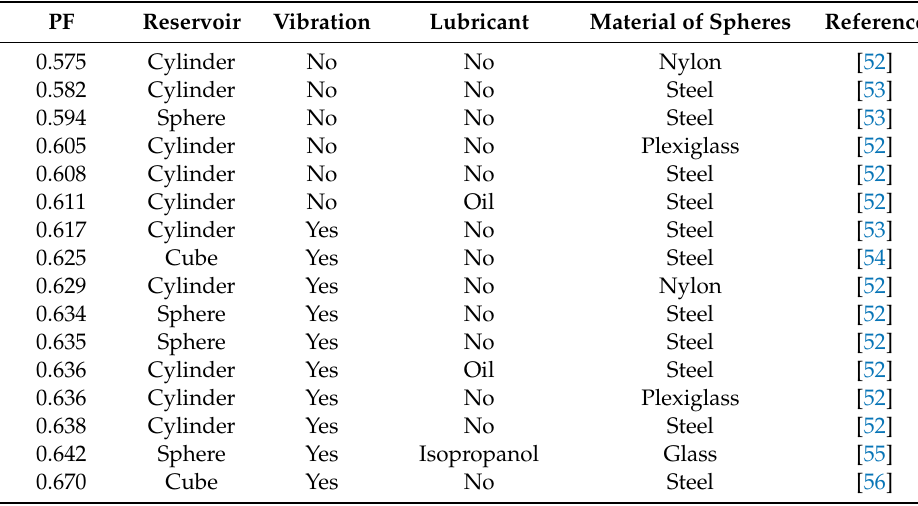
Table 9. Values of PF for several situations.